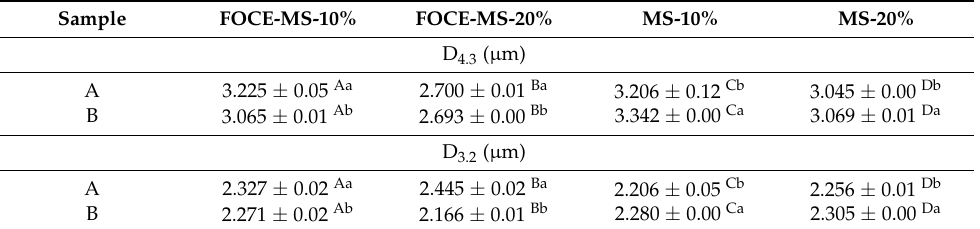
Table 5. Particle size distribution of